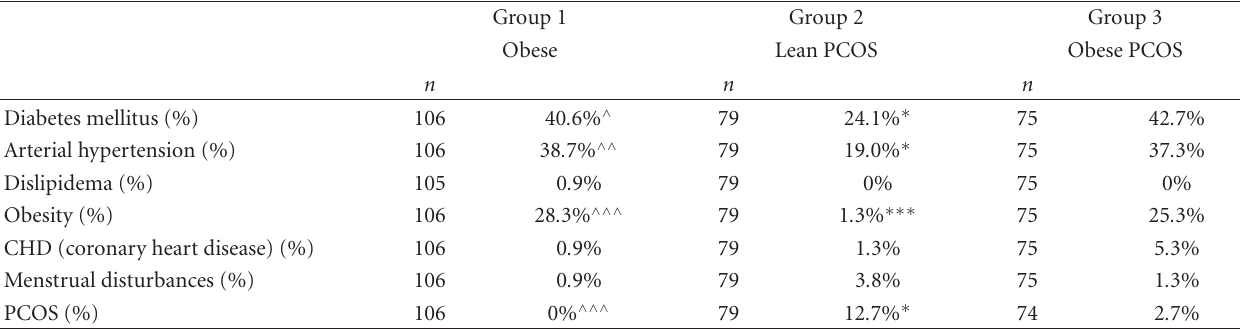
Table 5: Comparison between the family history for chronic diseases between the three groups.